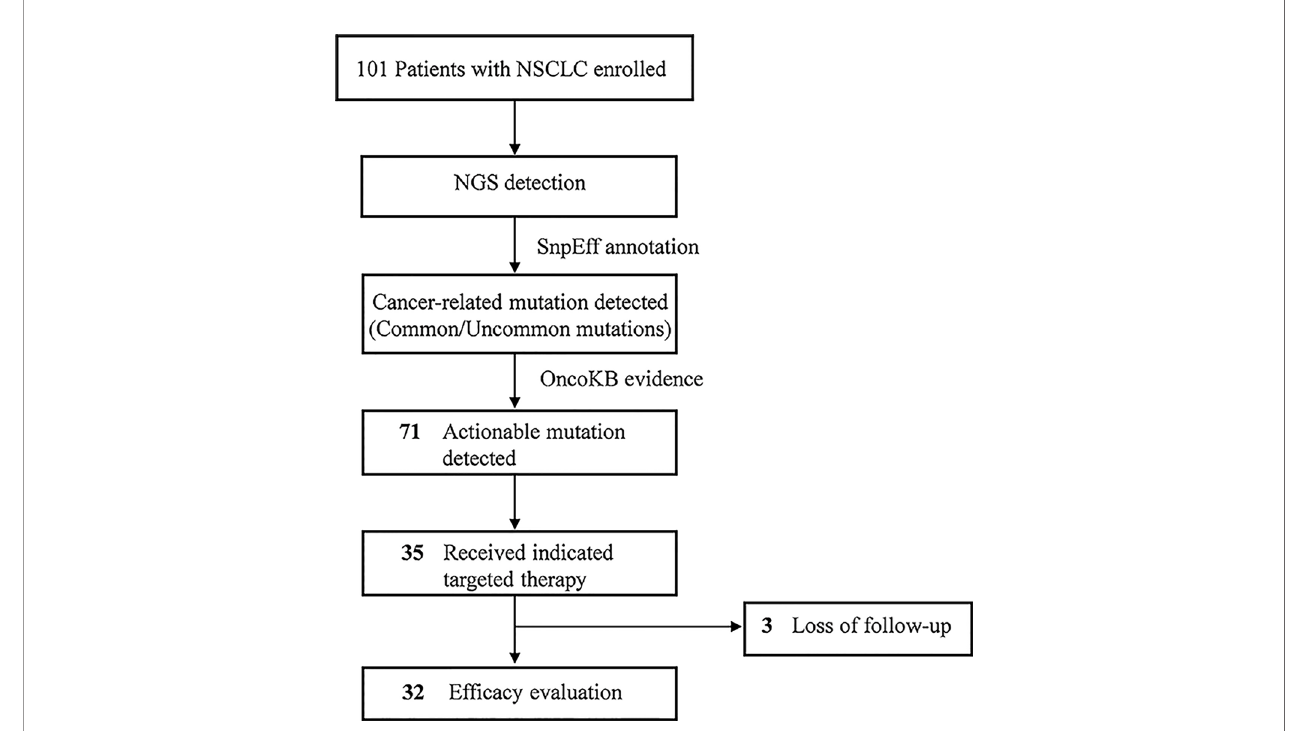
FIGURE 1 | Testing Flowchart of patients. Flowchart indicates patient enrollment, DNA panel conducted, cancer-related mutations detected and targeted therapies